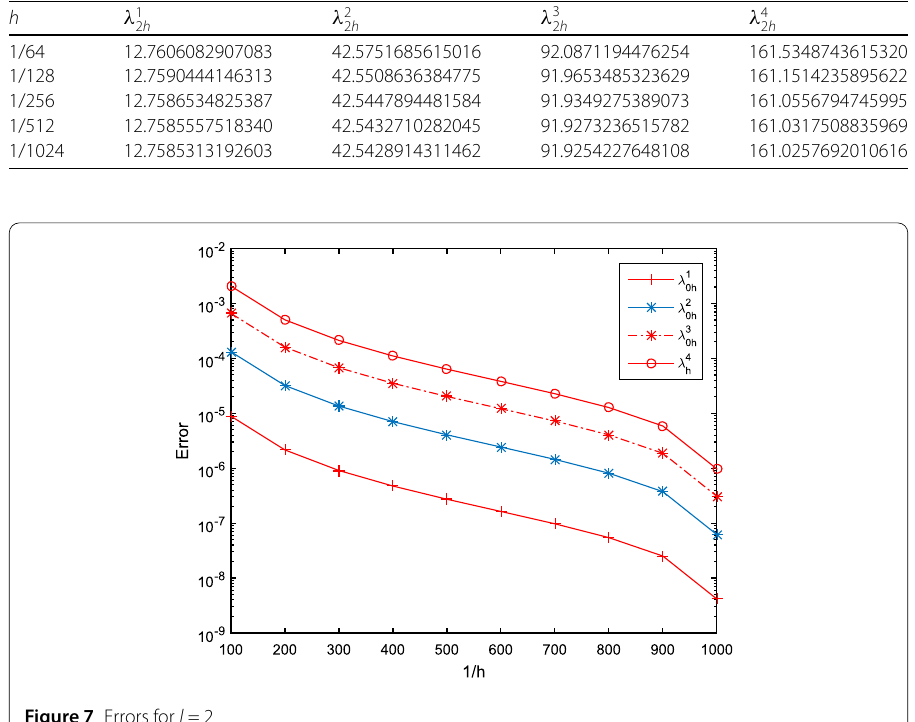
Figure 7 Errors for l =